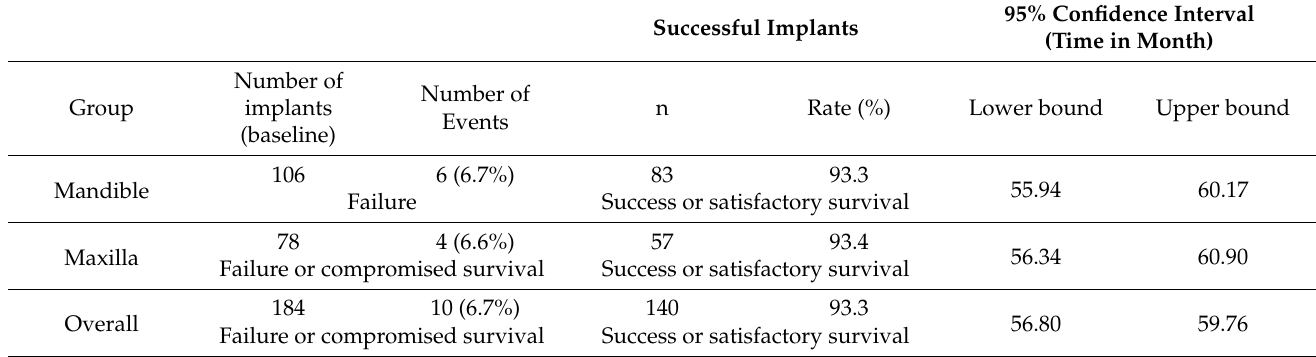
Table 3. Survival analysis of mini-implants after five years in function (failure, compromised survival, satisfactory survival, and success) at the implant level.